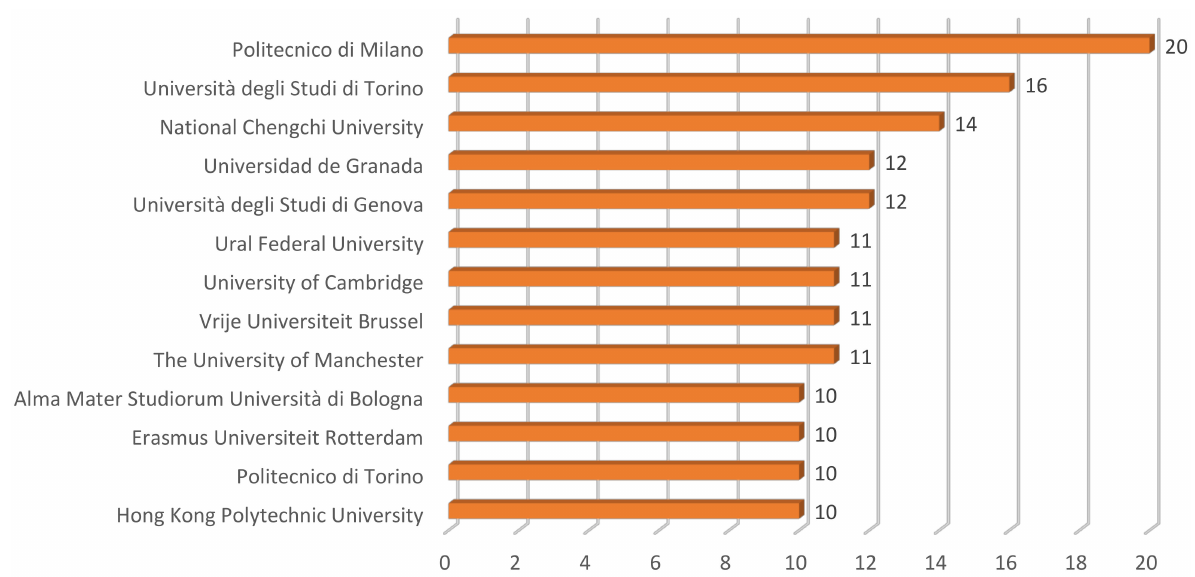
Figure 7. The list of the most often affiliated institutions (20 or more documents for the adopted period). This study also included an analysis of the results for each country in terms of the number of documents published. As in previous cases, due to the extensive dispersion of the published documents (almost 100 countries), these countries were selected for analysis. The number of published documents amounted to 50 or more in the tested period (Figure 8).